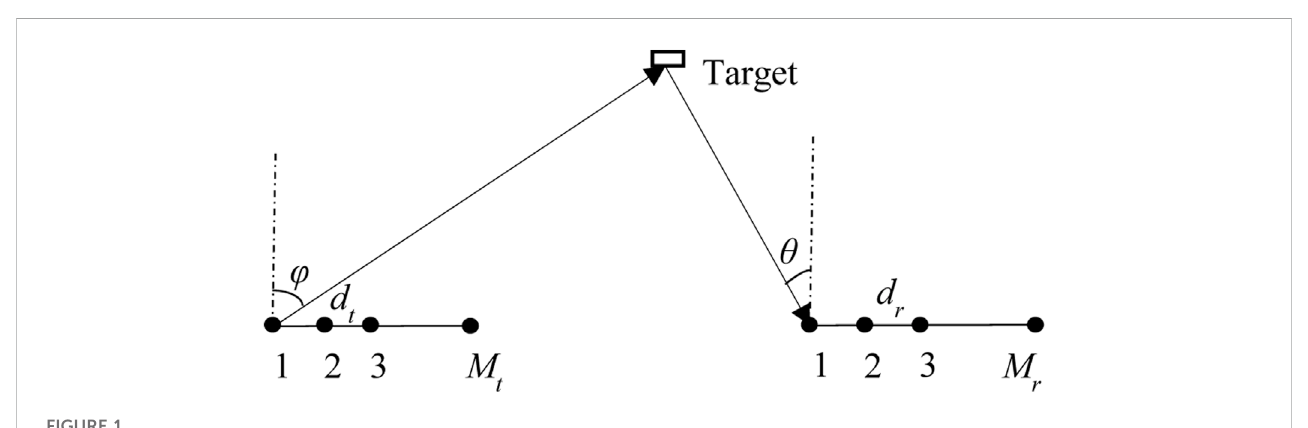
FIGURE 1 Signal model of the bistatic MIMO